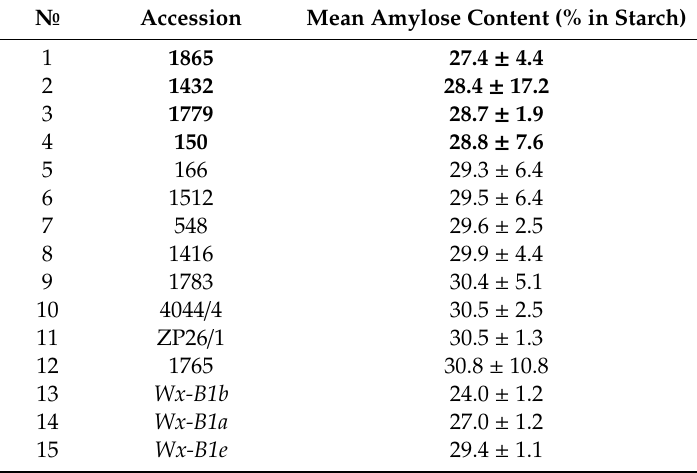
Table 2. Amylose content in wheat–wheatgrass accessions, common wheat lines with Wx-B1b ( null allele), Wx-B1a (wild-type allele, Nemchinovskaya 56) and Wx-B1e are used as controls. Confidence interval after ± is shown ( t -test, p = 0.05).